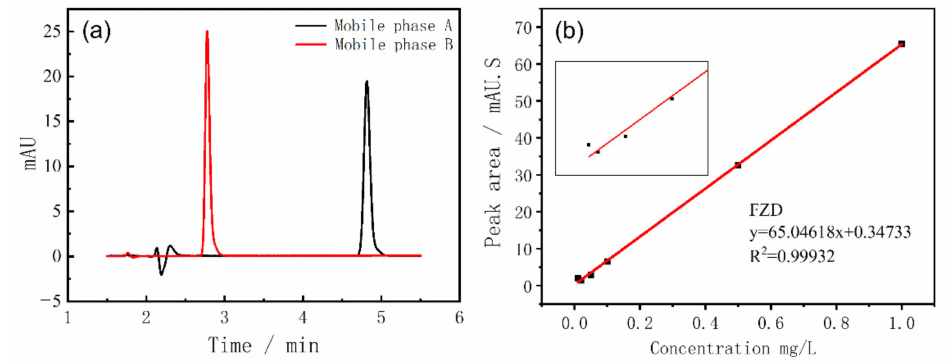
Figure 2. ( a ) Chromatograms of FZD standard solution with different mobile phases; ( b ) the FZD calibration curve. A local enlargement of the curve is shown in the